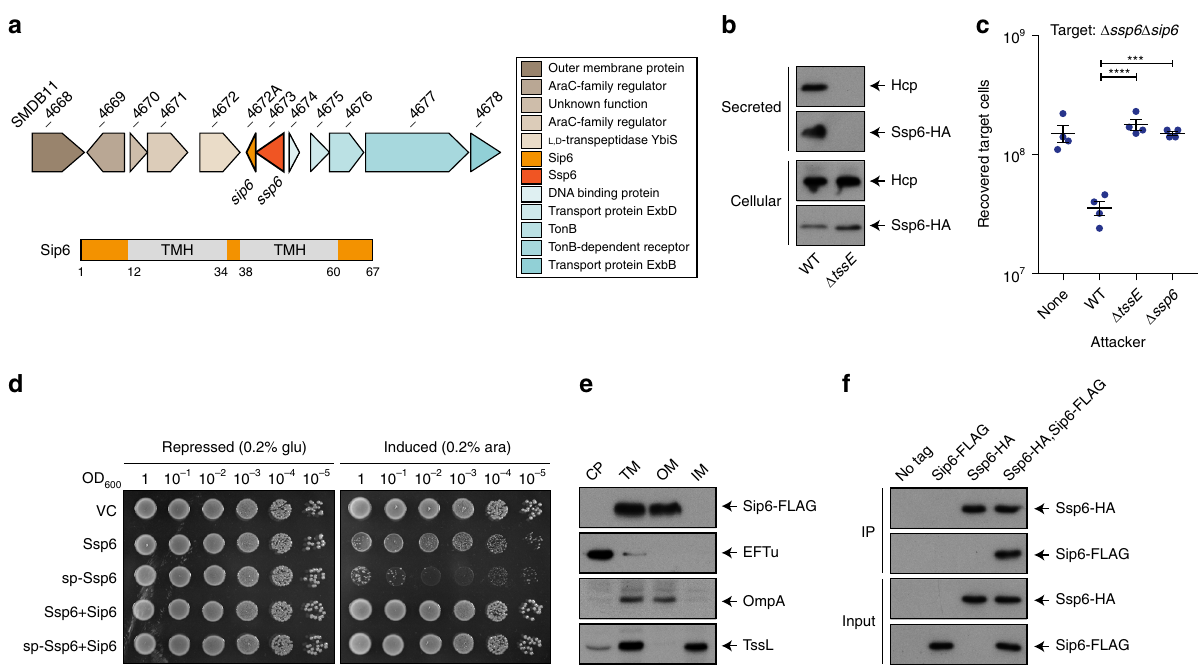
Fig. 1 Ssp6 is a T6SS-delivered toxin and Sip6 is its cognate, membrane-associated immunity protein. a Schematic representation of the genomic context of the genes encoding Ssp6 and Sip6, with genomic identi fi ers (SMDB11_xxxx) provided above each gene and predicted protein functions in the box to the right. Below, the positions of the two transmembrane helices (TMH) in Sip6, predicted using TMHMM v. 2.0, are indicated, where numbers refer to amino acids. b Immunoblot detection of Hcp1 and Ssp6-HA in cellular and secreted fractions of S. marcescens Db10 carrying the chromosomally-encoded Ssp6-HA fusion in either an otherwise wild type (WT) or T6SS-inactive ( Δ tssE ) background. c Number of recovered Δ ssp6 Δ sip6 target cells following co-culture with wild type (WT), Δ tssE or Δ ssp6 mutant strains of S. marcescens Db10 as attackers. Individual data points are overlaid with the mean + / − SEM ( n = 4 biological replicates; *** p < 0.001, **** p < 0.0001, one-way ANOVA with Dunnett ’ s test); none, target cells incubated with sterile media alone. d Growth of E. coli MG1655 carrying empty vector control (VC, pBAD18-Kn) or plasmids directing the expression of native Ssp6 (Ssp6) or Ssp6 fused with an N- terminal OmpA signal peptide (sp-Ssp6), each with or without Sip6, on LBA containing 0.2% D -glucose or 0.2% L -arabinose to repress or induce, respectively, gene expression. e Cells of S. marcescens Db10 carrying chromosomally-encoded Sip6-FLAG were subjected to subcellular fractionation and analysed by immunoblot detection of the FLAG epitope, EFTu (cytoplasmic control protein), TssL (inner membrane control protein) and OmpA (outer membrane control protein). CP cytoplasm, TM total membrane, OM outer membrane, IM inner membrane. f Co-immunoprecipitation of Ssp6-HA and Sip6-FLAG. Total cellular protein samples from wild type S. marcescens Db10 (no tagged proteins) and strains carrying chromosomally-encoded Ssp6-HA, Sip6-FLAG, or Ssp6-HA and Sip6-FLAG, were subjected to anti-HA immunoprecipitation, with resulting eluate (IP) and input samples analysed by immunoblot. Source data are provided as a Source Data fi